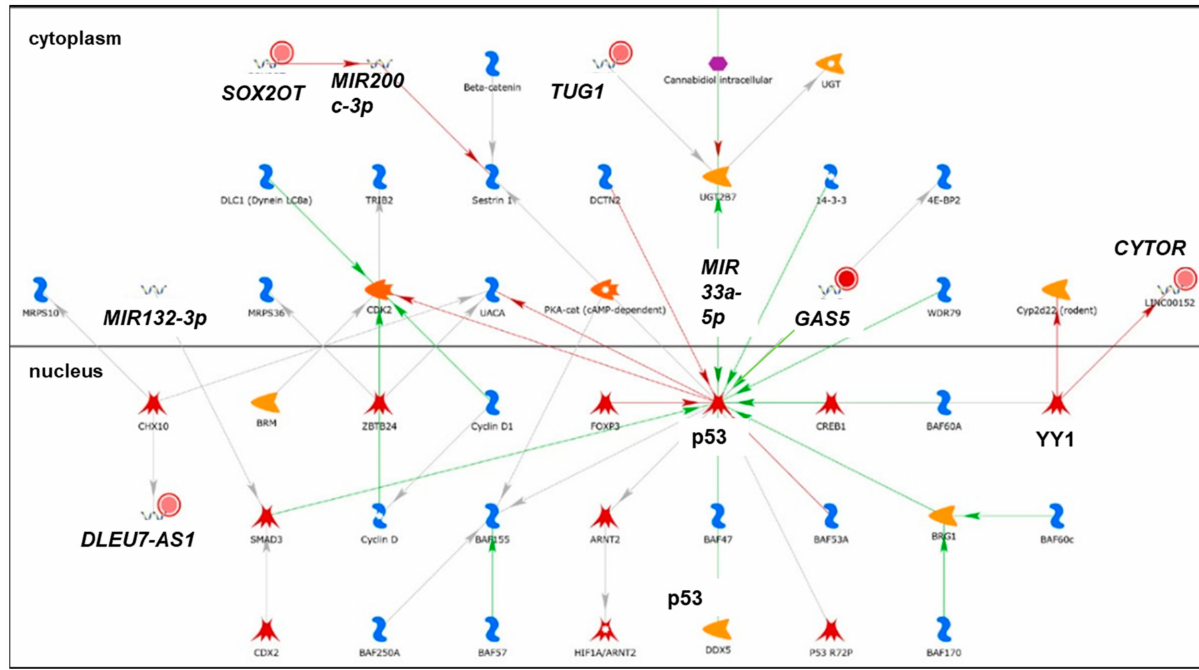
Figure 3. Network 3: DLEU7-AS1, GAS5, SOX2OT, LINC00152, and TUG1 , identified in lncRNAs downregulated by miR-29b-1-3p and miR-29a-3p in MCF-7 and or LCC9 cells by MetaCore analysis. Green lines with arrows = stimulation; red lines with arrows =